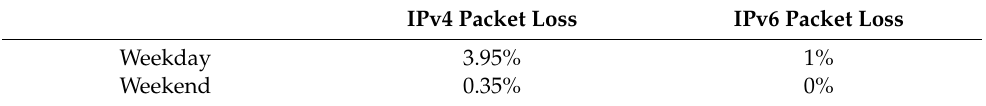
Table 2. Packet loss in connectivity test.